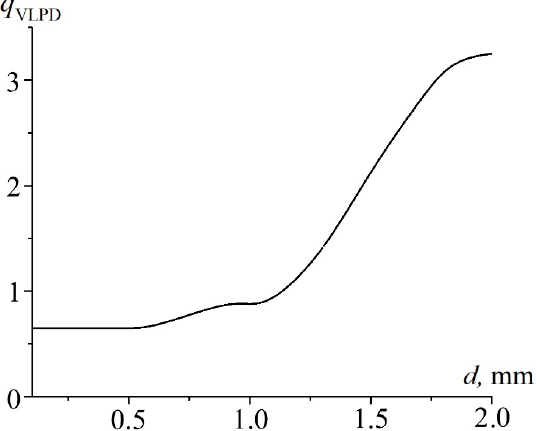
Figure 7. Dependence of the average charge q VLPD on the size of the defect “rod-end fitting”.